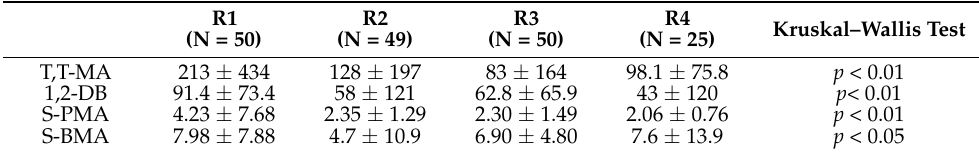
Table 3. BTEX metabolite concentrations ( µ g · g − 1 crt) and spatial differences by Kruskal–Wallis test (GM ± SD).